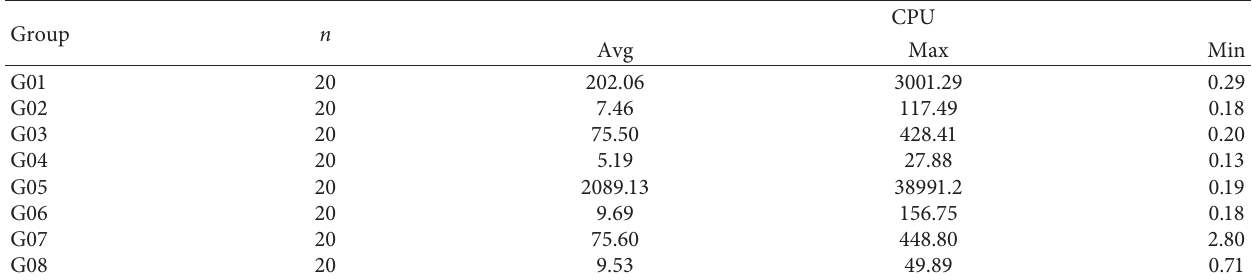
Table 4: CPU time of CPLEX solutions in TPP problem.